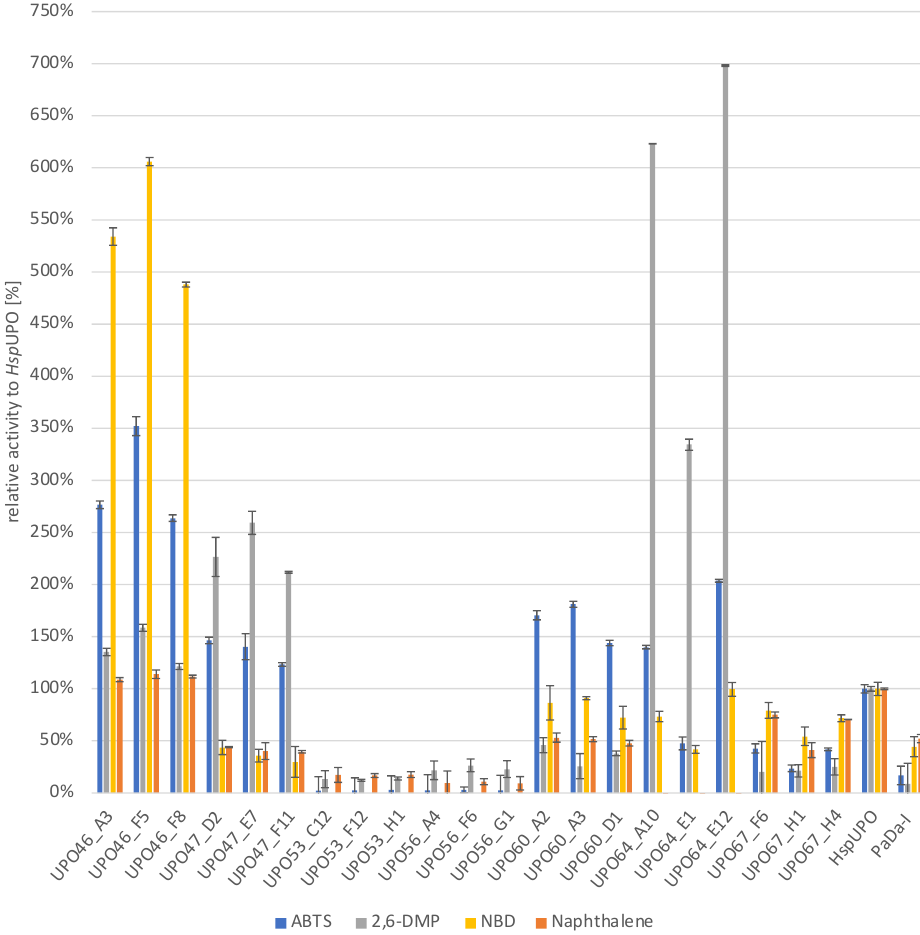
Figure 2. Microscale rescreening of K. phaffii strains expressing selected novel UPOs. For each UPO target, three different strains were cultivated. Each strain was cultivated in triplicates and enzymatic activities of supernatants were determined. The different strains per UPO target were named ac- cording to the shortcut (e.g., UPO46) and a clone designation reflecting the position of this clone in the initial cultivation (e.g., _A3). Values are depicted as change of absorbance per time (mAU/min) relative to values of the control Hsp UPO (100%). Absorbance was determined for ABTS, 2,6-DMP and NBD at 405 nm, 469 nm and 425 nm, respectively. Error bars represent the variance. All values are corrected by the measurements for the control strain not expressing any target protein.